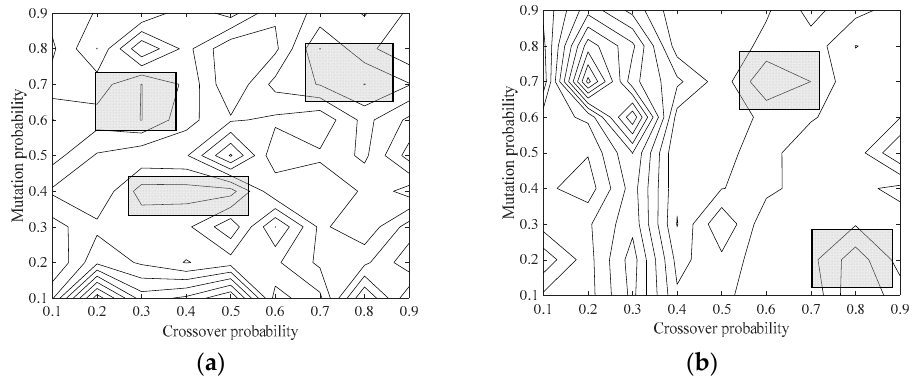
Figure 10. Influence of crossover and mutation probabilities on solutions. ( a ) Influence of crossover and mutation probabilities on the solutions; ( b ) Influence of crossover and mutation probabilities on solving time.